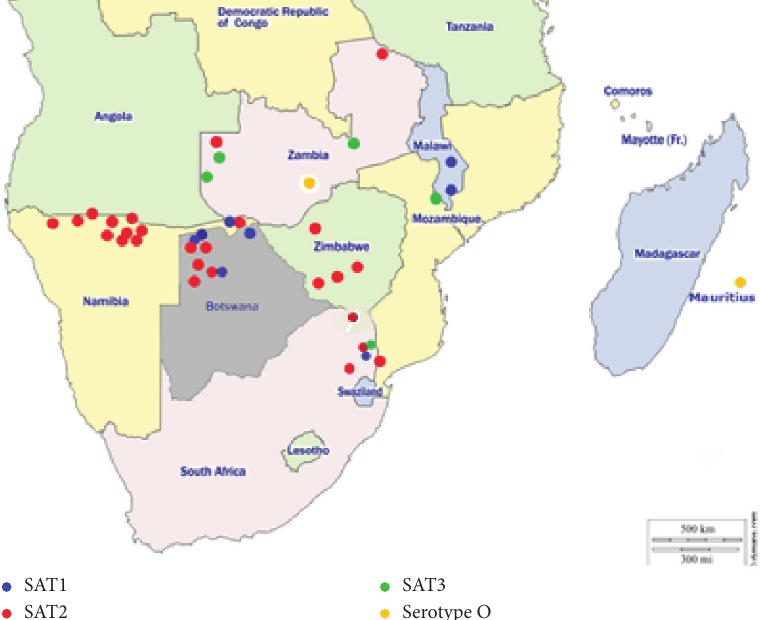
Figure 2: Map of southern Africa depicting FMD distribution between 2014 and 2018, by serotype (adapted with permission from http://